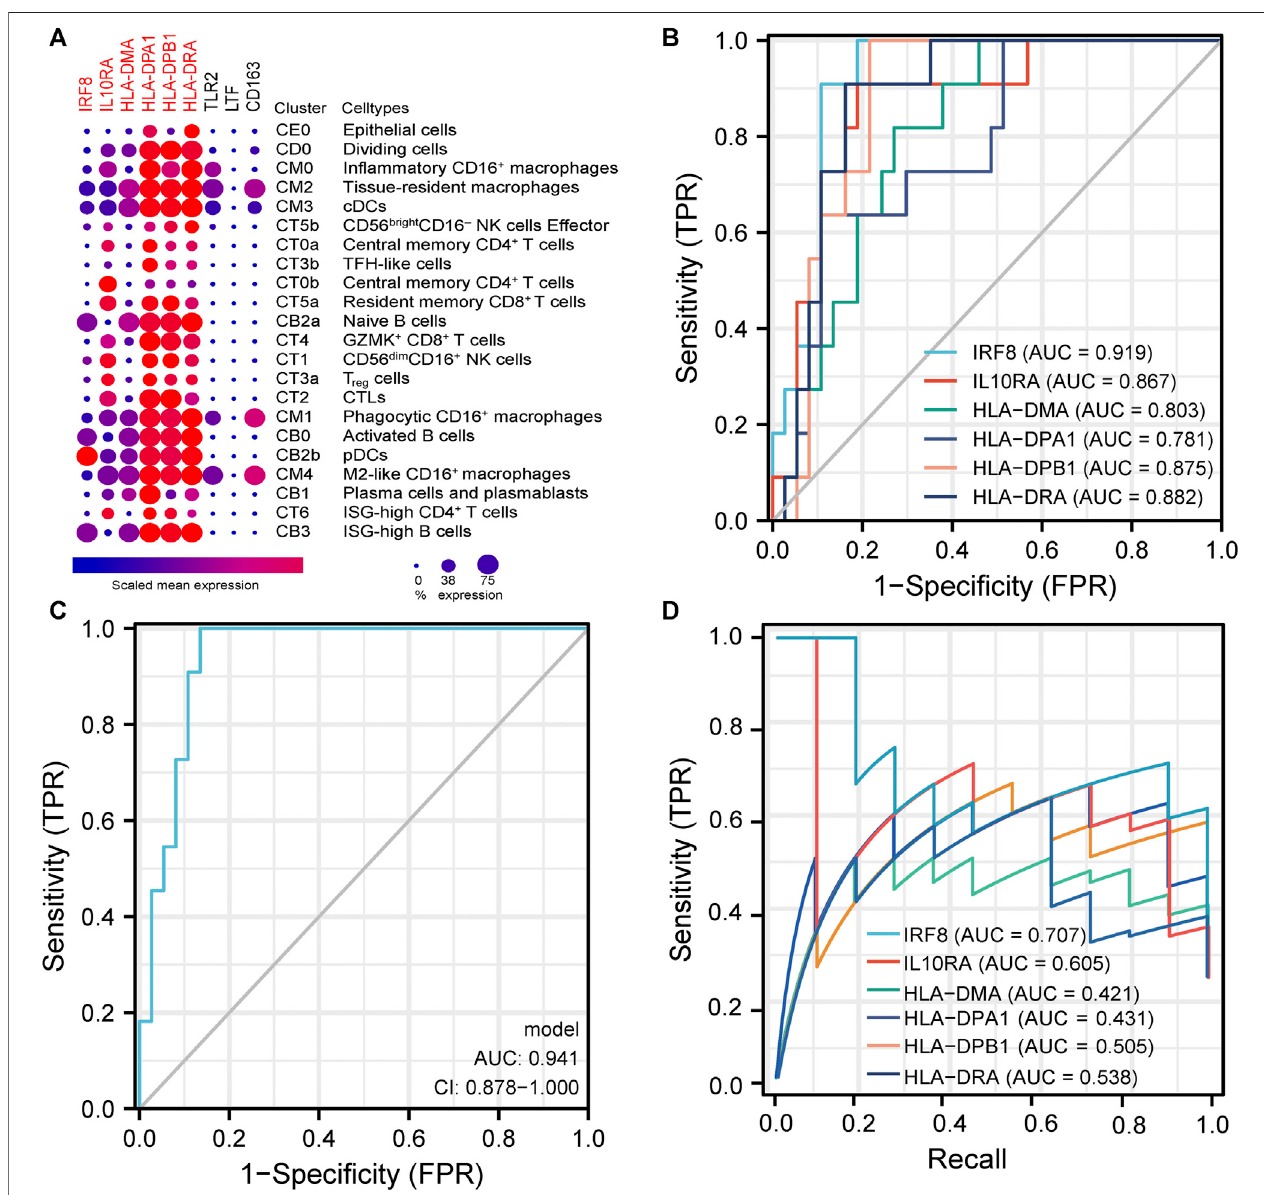
FIGURE6|| Analysisofimmunecelldistributionanddiagnosticef fi cacyofLNbiomarkers (A) .Expressionofco-DEGsindifferentimmunecelltypesinthesinglecell LNsequencing database. (B) ROCcurvesofsixdifferentially-expressedgenesspeci fi ctoLNinGSE60861. (C) ROCcurvewithoptimal minimalgeneset( IRF8 , IL10RA , HLA-DMA , HLA-DPA1 ) in GSE60861. (D) Precision-Recall Curves of six differentially-expressed genes speci fi c to LN in GSE60861.